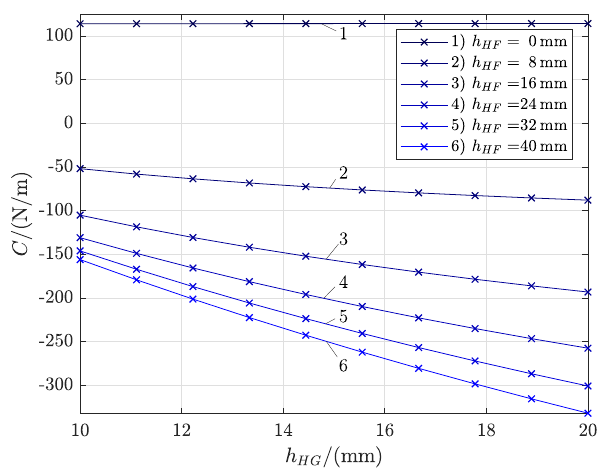
Figure 5. The destabilizing effect of the h HG -adjustment decays with a decreasing distance between joint F and joint H. In case h HF becomes negative, the stiffness even increases slightly. For h HG and h HF , see Fig.